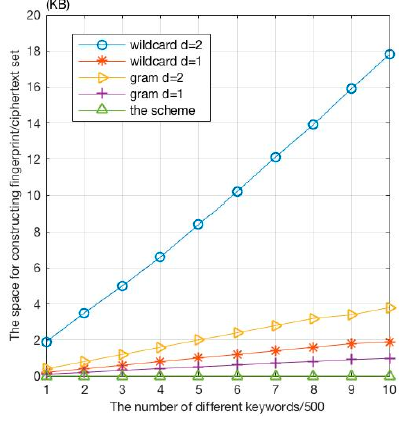
Figure 4. Spatial overhead of constructing the fuzzy set.